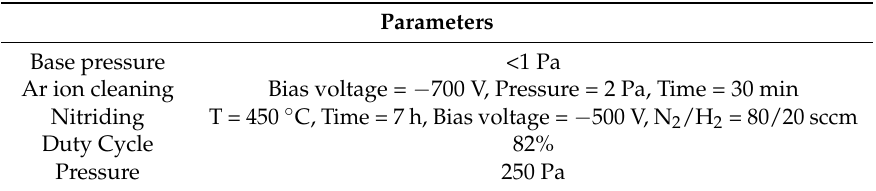
Table 1. Parameters for plasma nitriding.